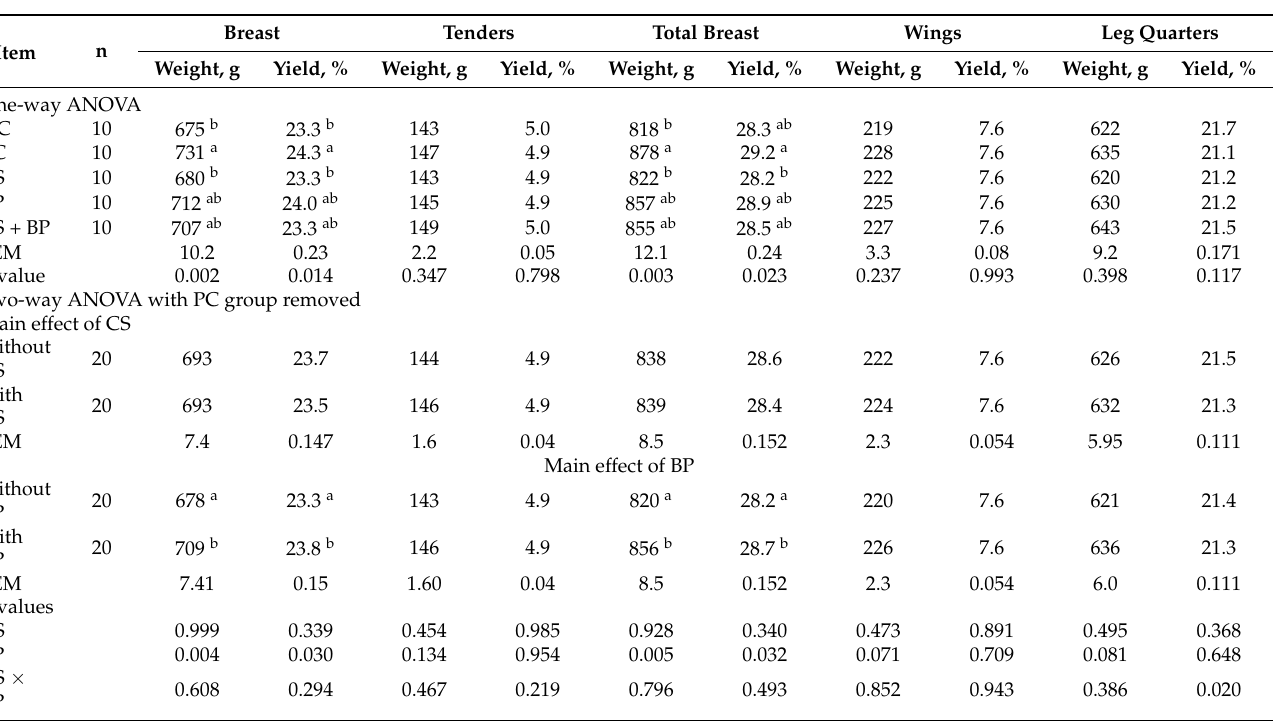
Table 6. Parts weights and yields of broilers fed diets with and without bacitracin methylene disalicylate or various antibiotic alternatives from 0 to 47 d post-hatch and processed at 48 d post- hatch 1 .